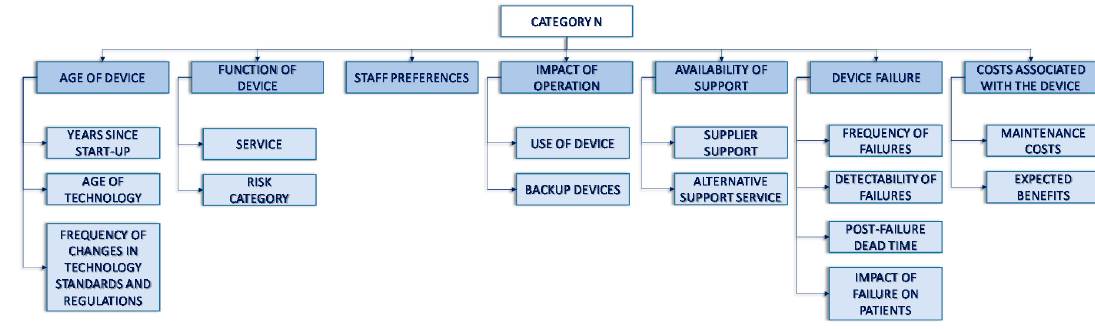
Figure 2. Total structure by category N.